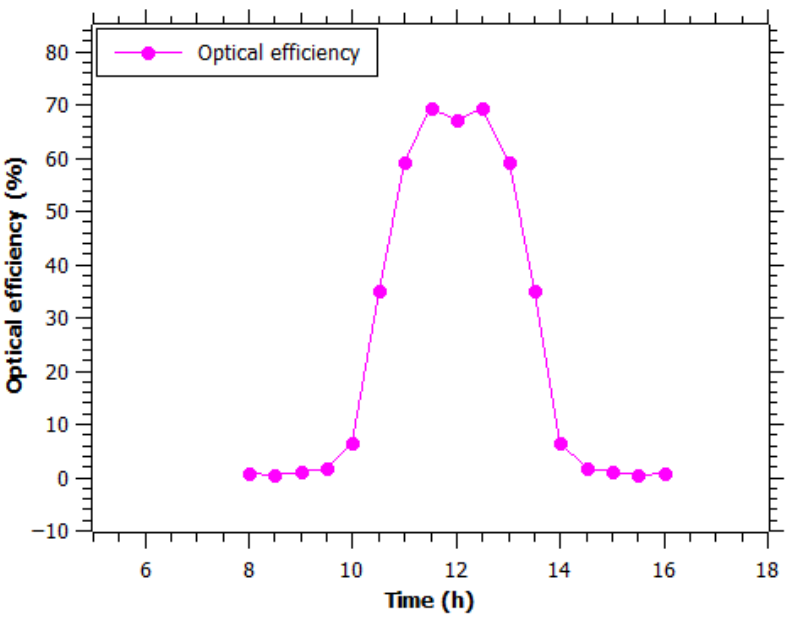
Figure 9. Experimental optical